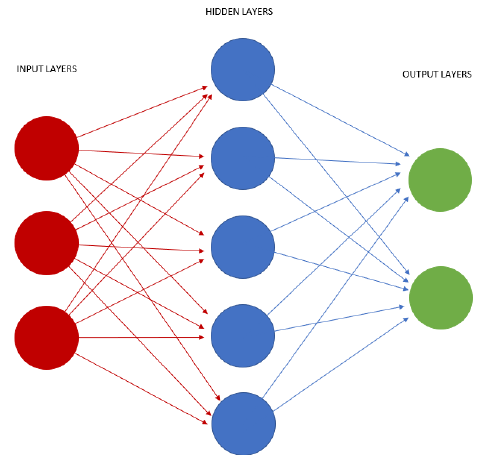
Figure 4. Example of a structure of a simple Neural Network